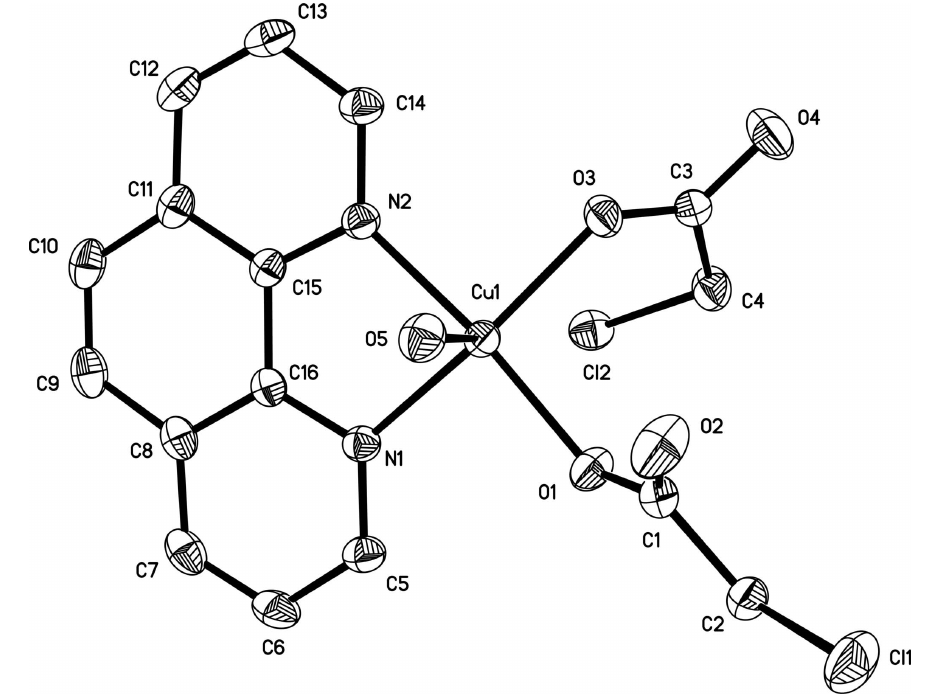
The molecular structure of (I) with atomic numbering and 30% probability displacement